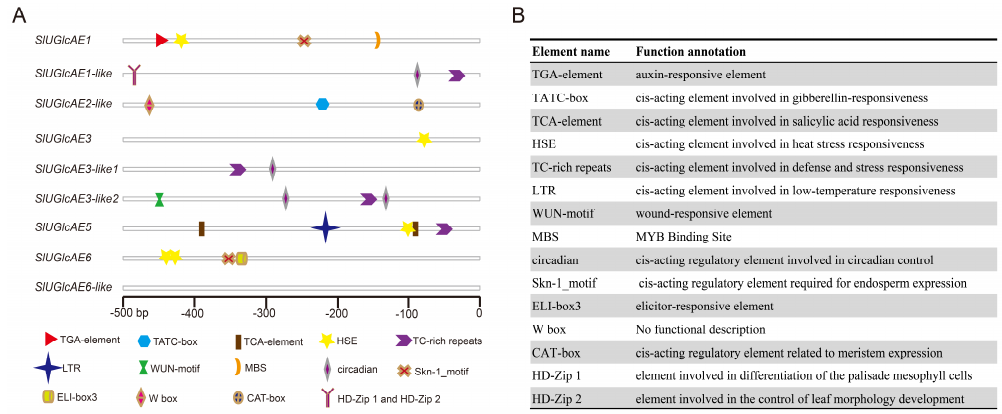
Figure 8. Kinds and numbers of stress‐related, hormone‐related, and development‐related cis ‐elements in the upstream of SlUGlcAE genes. ( A ) Various symbols indicate different cis ‐acting elements; and ( B ) Element names and their functional descriptions.